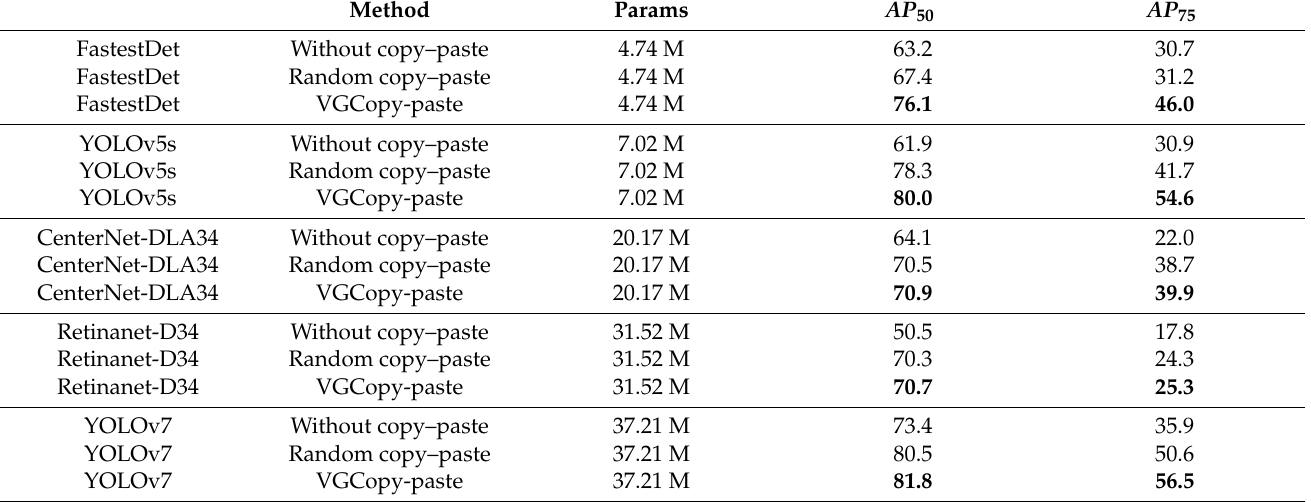
Table 3. Road manhole cover detection on our test set, where “Without copy-paste” denotes the abnormal manhole cover images that are added to the training set without additional processing. “Random copy-paste” denotes extracting abnormal manhole cover samples and random pasting onto the training set. “VGCopy-paste” denotes extracting abnormal manhole covers and using VGCopy-paste. AP50 and AP75 evaluation metrics are adopted from